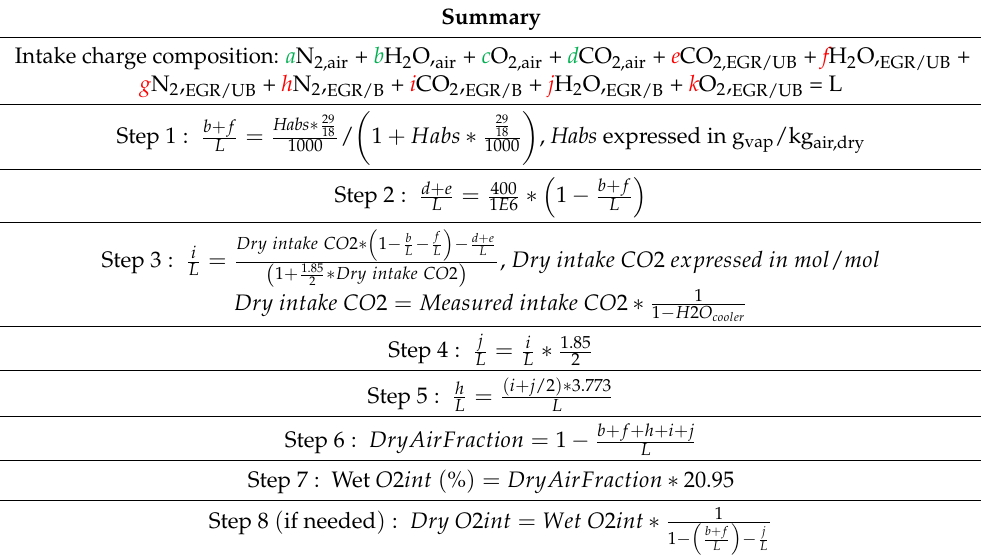
Table 4. Summary of the methodology, based on intake CO 2 dry concentration and ambient humidity measurements, used to estimate intake O 2 concentration.